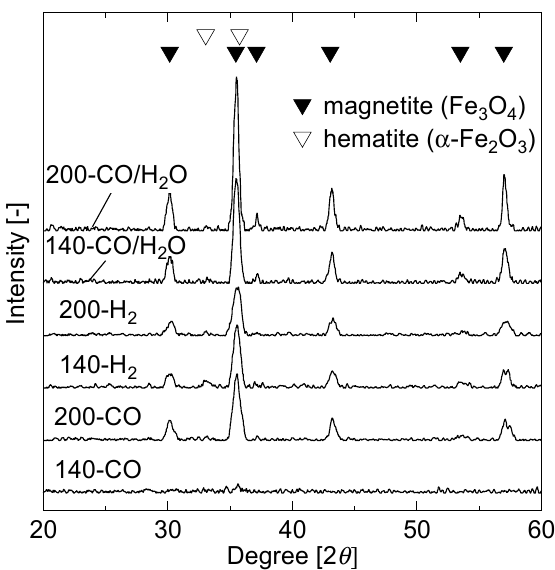
Figure 4. XRD patterns of the reduced